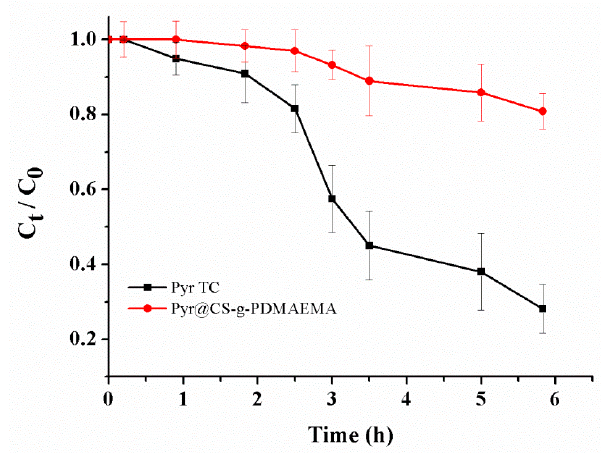
Figure 10. Photodegradation of pyraclostrobin TC and microcapsules under high-pressure mercury lamp. Table 2. Photolyses of pyraclostrobin TC and microcapsules under high-pressure mercury lamp. Analytes a